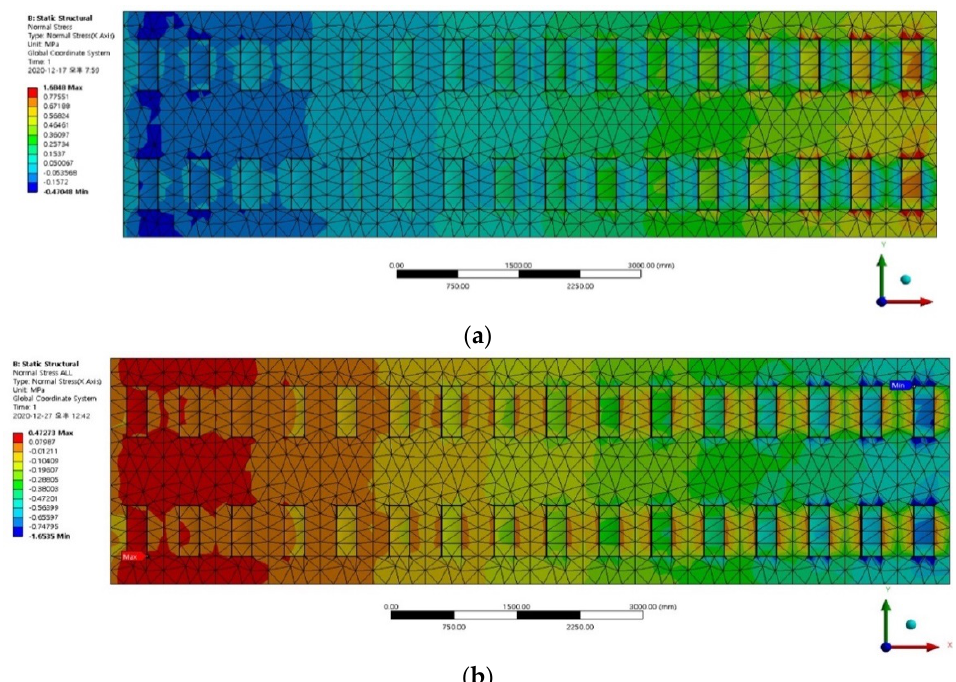
Figure 10. FE analysis results (normal stress on the top surface of the concrete bed, x direction) for ( a ) 5 mm uplift or ( b ) 5 mm subsidence (positive is tension).